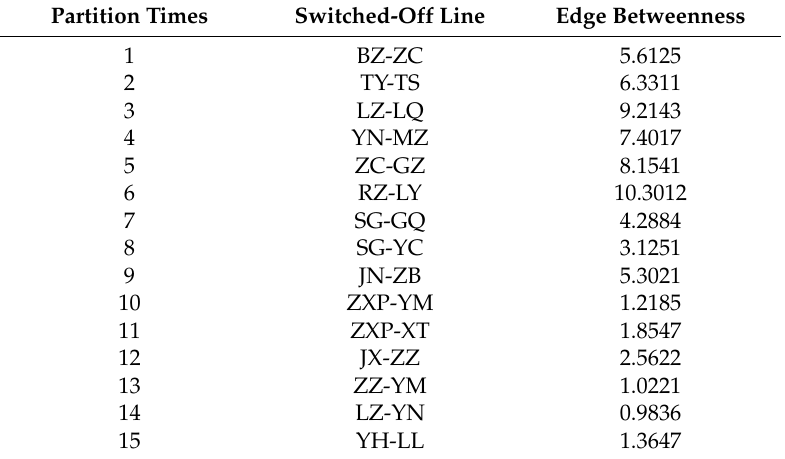
Table 3. Computation Results of Edge